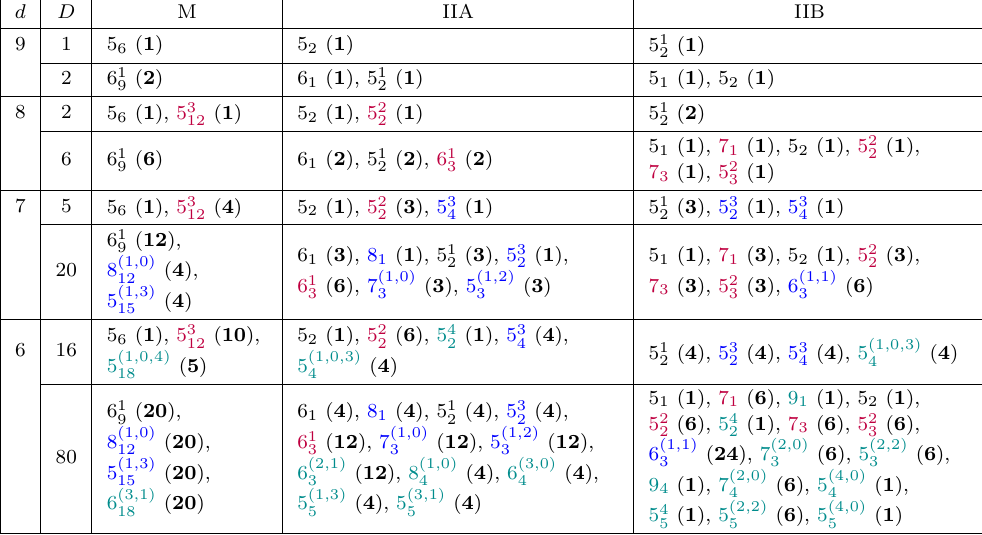
Table 12 . Branes in the 5-brane multiplet.